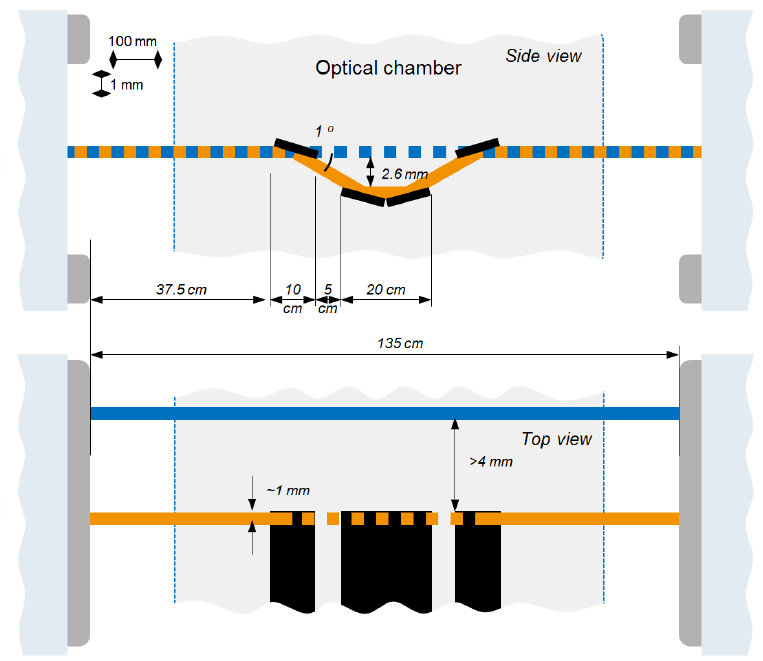
Figure A3. Concept of optical delay line, located between the second and third dipoles. Electrons are deflected in the horizontal plane, radiation in the vertical plane. For illustration purposes, the mirror thickness is